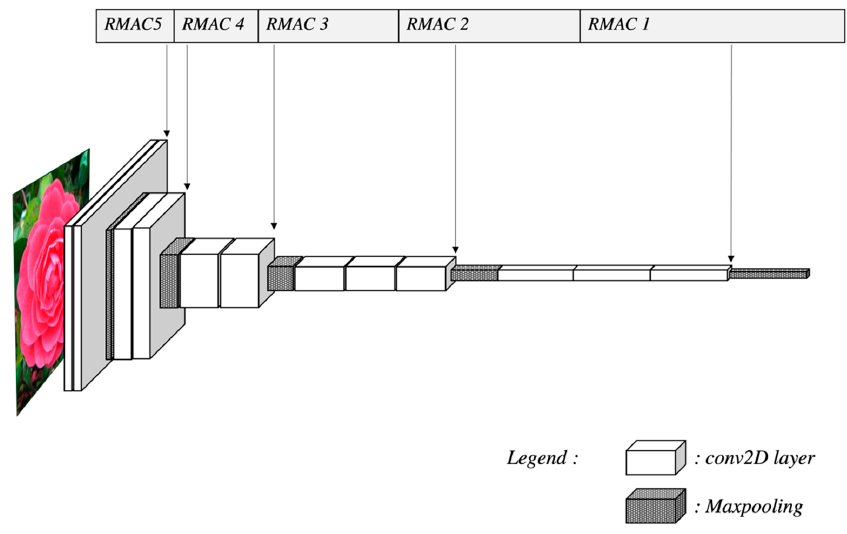
Figure 14. Illustration of localization RMAC layers to form MS-RMAC in VGG16.